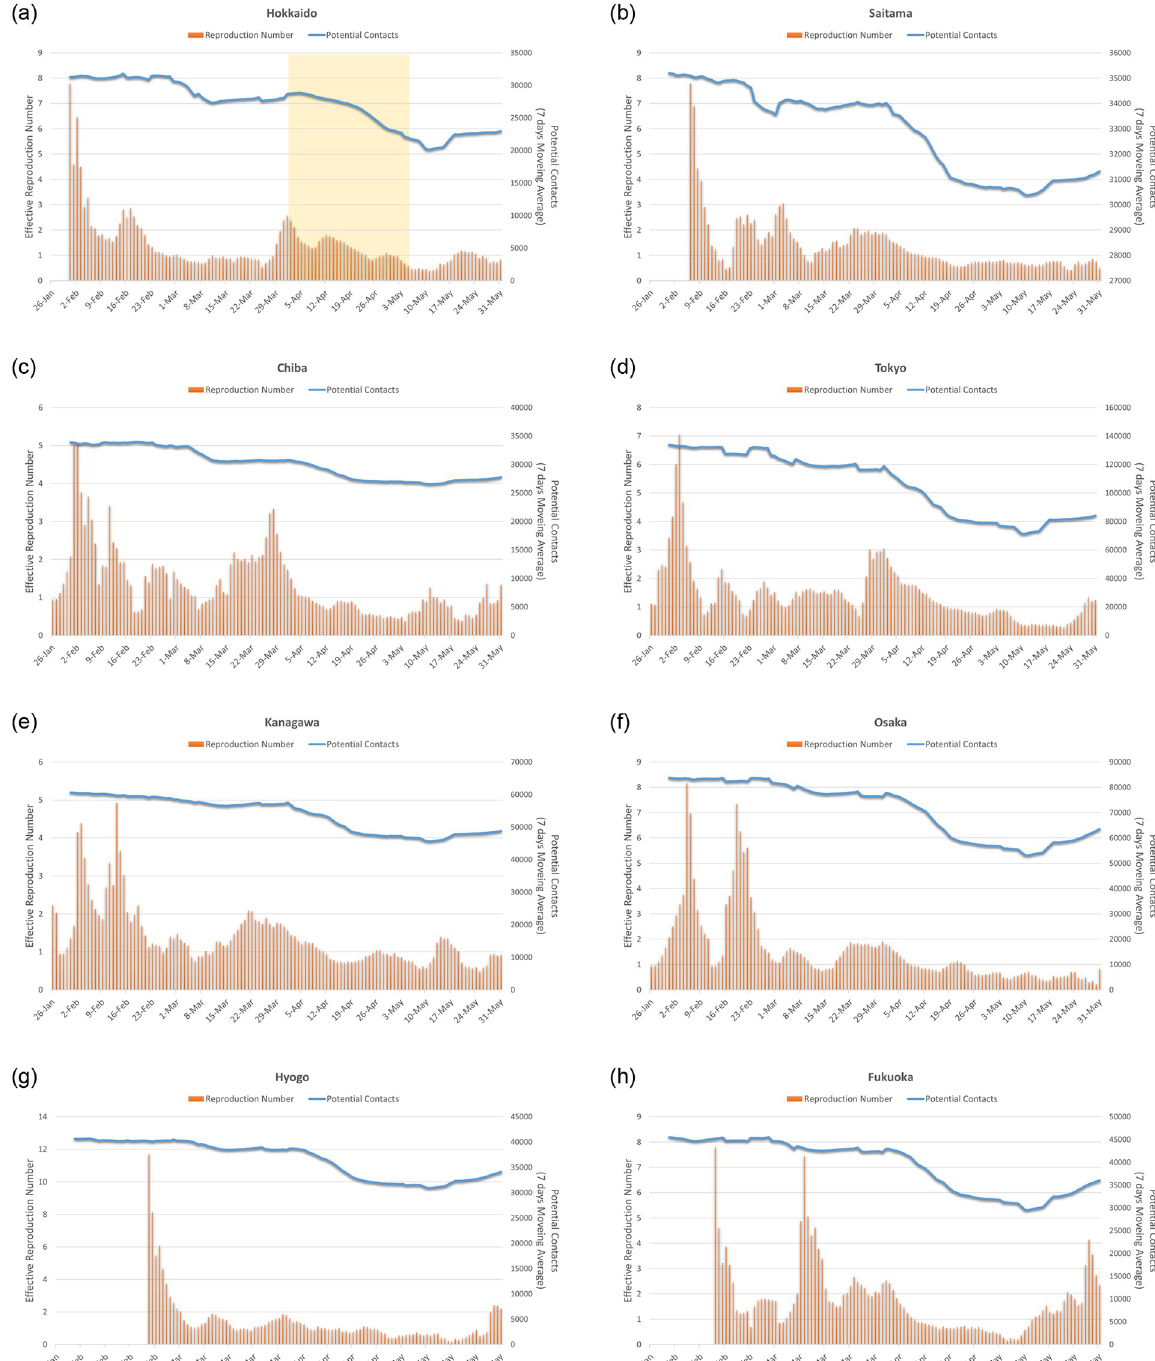
Fig 4. Effective reproduction number (R (T)) and measure of potential contacts ( PC ð T (cid:0) 5 Þ ) in the eight prefectures (5 days lag for potential contacts is assumed, e.g., PC ð T (cid:0) 5 Þ on March 27 th is plotted on April 1).